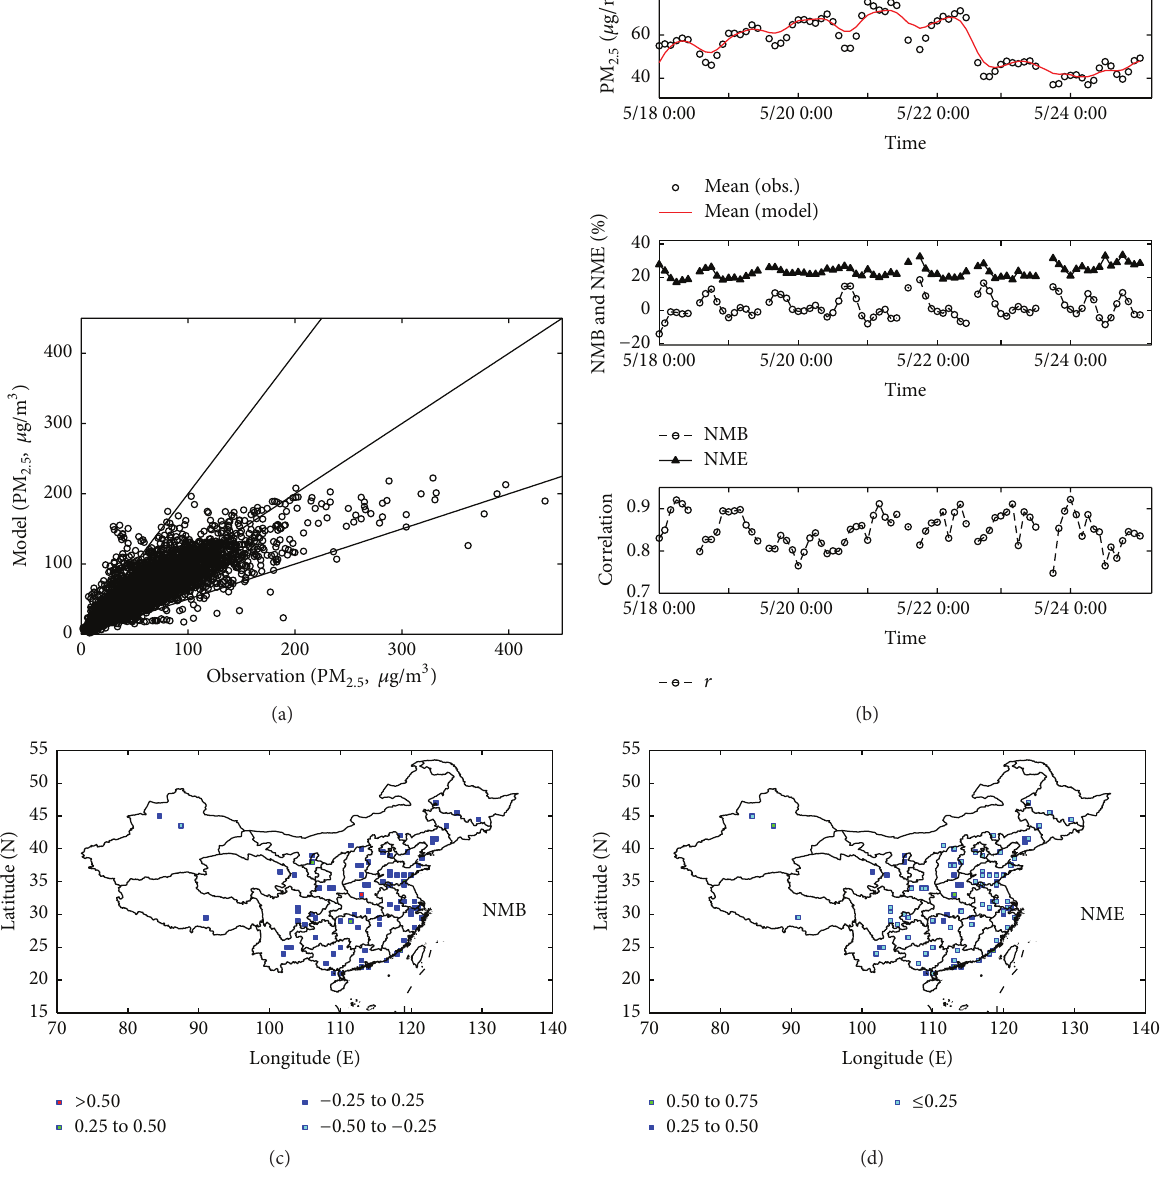
Figure 8: Comparison of the modeled and observed PM 2.5 concentrations in PE1: (a) scatterplot ( 𝜇 g/m 3 ) (the 1: 2, 1: 1, and 2 : 1 lines are shown for reference), (b) temporal variation of spatial mean, NMB, NME, and correlation, and spatial distribution of (c) NMB and (d)